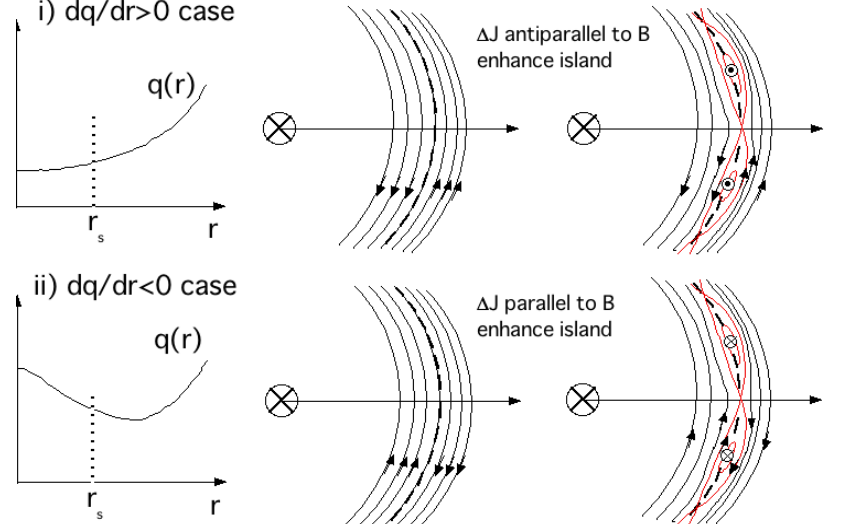
Figure 25. Relative magnetic field line flow inside and outside of resonant surface in equilibrium, the formation of magnetic island by the magnetic reconnection shown by red line for i) positive magnetic shear s = rdq/dr/q > 0 case and ii) negative magnetic shear s = rdq/dr/q < 0